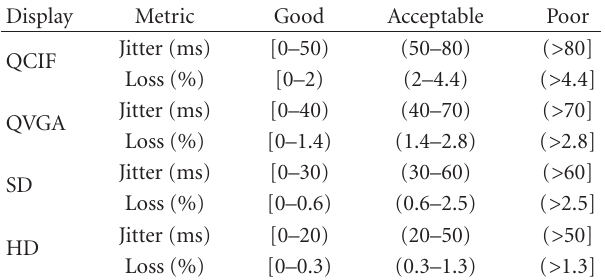
Table 5: Jitter and loss GAP ranges under